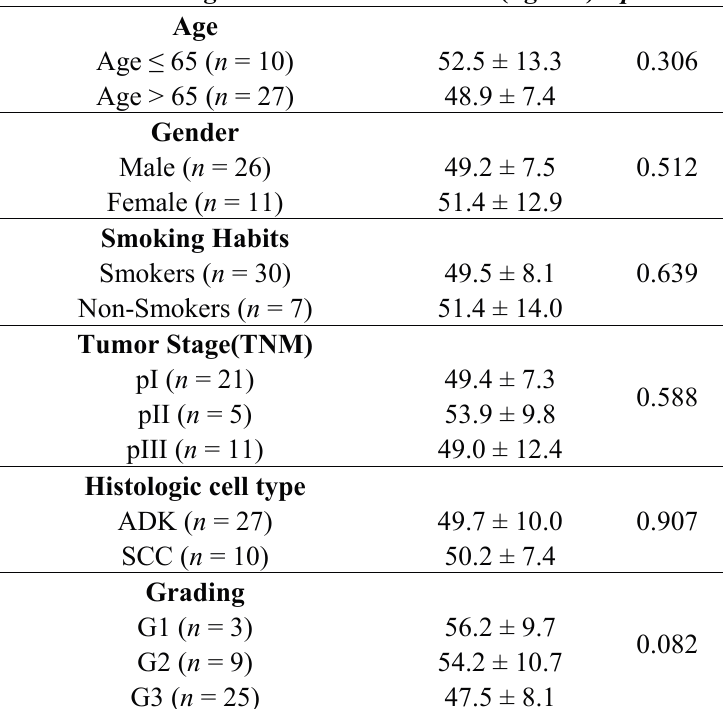
sEGFR, soluble epidermal growth factor receptor; ADK, adenocarcinomas; SCC, squamous cell